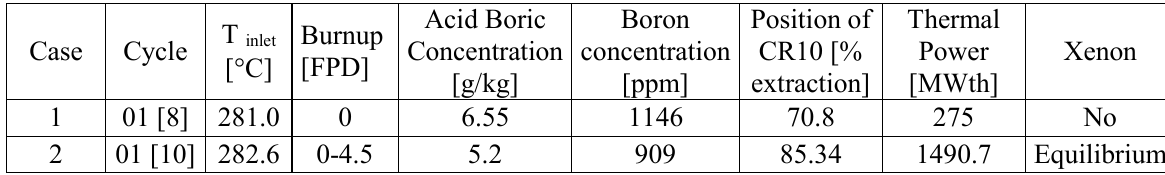
Table II: Reactor states to be calculated within this work. Details can be gathered from